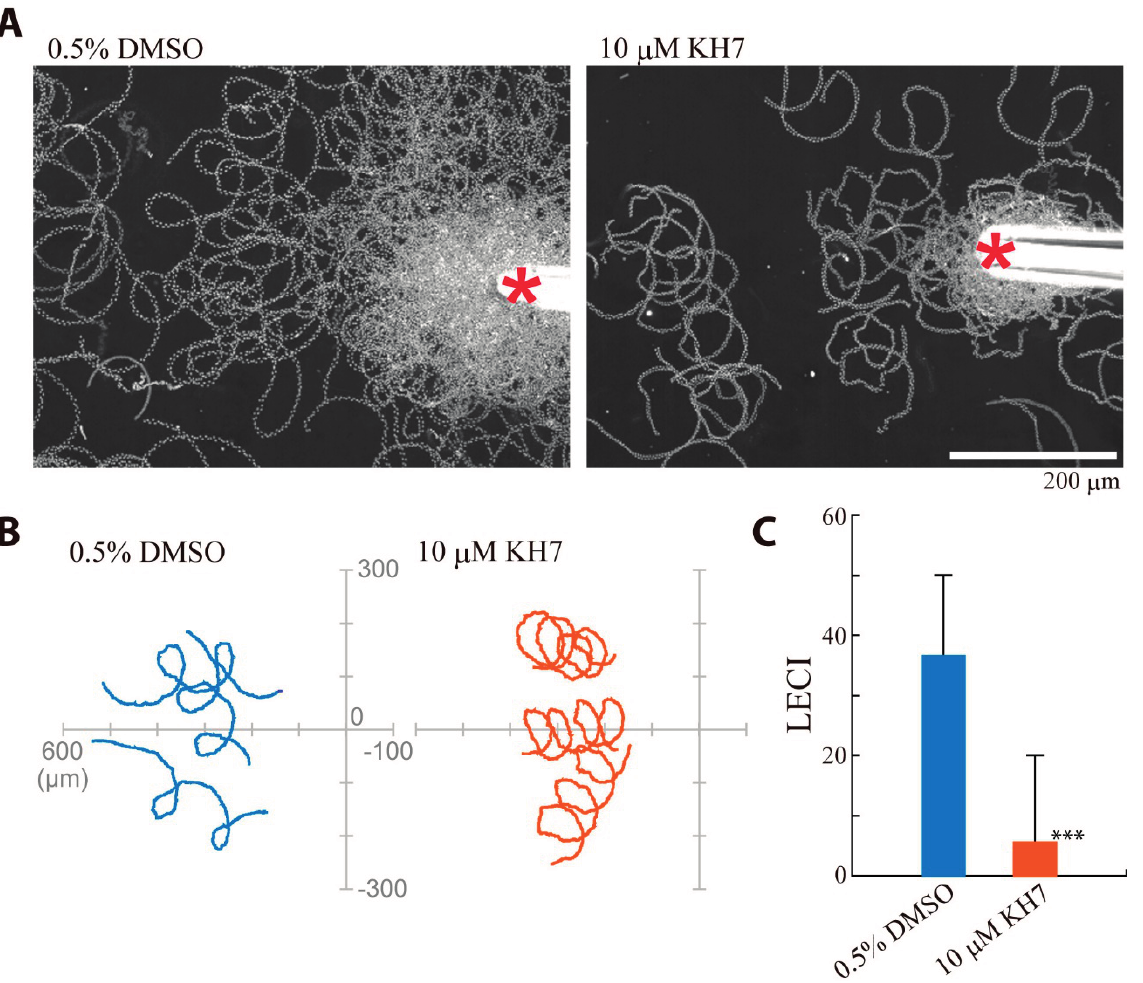
Figure 6. Effects of sAC inhibitor KH-7 on chemotaxis of Ciona sperm. ( A ) Swimming trajectories during 2 s of sperm treated with 0.5% DMSO (control, left ) and sperm treated with 10 μ M KH-7 ( right ). The photo was integrated from 200 images taken at 100 fps. The red asterisks represent the tip of glass capillary filled with SAAF; ( B ) Sperm path trajectories of three representative sperm are shown; and ( C ) Comparison of linear equation chemotaxis indices (LECI) showing significant inhibition of chemotaxis by KH-7. Values are means ± SE. n = 29 (control) and 34 (KH-7). *** Significant at p < 0.001 (Student’s t -test) as compared with the